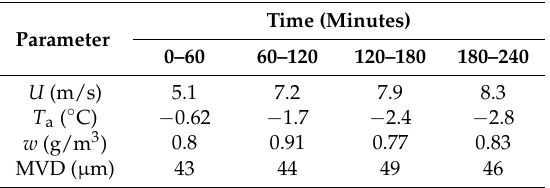
Table 3. Average climate parameters used for simulation.